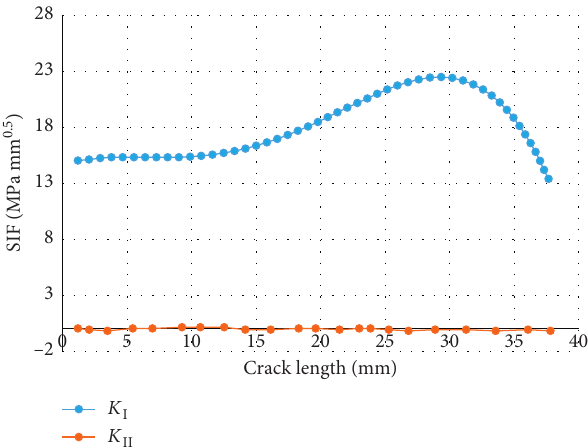
Figure 7: Relationship between SIFs and crack length for crack 2.